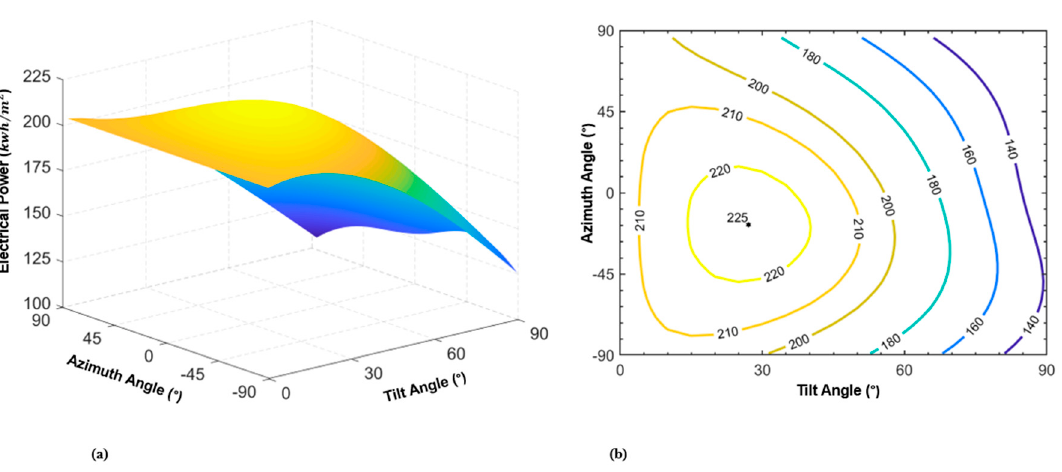
Figure 6. Surface and contour plots of DC electric power per square meter generated by PV panel versus panel orientation in Orlando Florida, USA. ( a ) Presents the shape of the change in DC power [ kWh/m2 ] versus the Tilt angle and the Azimuth angle. The surface plot presents a concave shape with an optimum value of 225 kWh/m 2 . The DC power decreases sharply for the tilt angle above optimum orientation. ( b ) Shows the contours of the DC power [kWh/m 2 ] versus the tilt angle and the azimuth angle. The starred point represents the optimum tilt angle of 26.2° and the azimuth angle of − 17.6°. While DC power is more sensitive to change in tilt angle, small changes in both tilt angle and azimuth angle result in a negligible power loss.